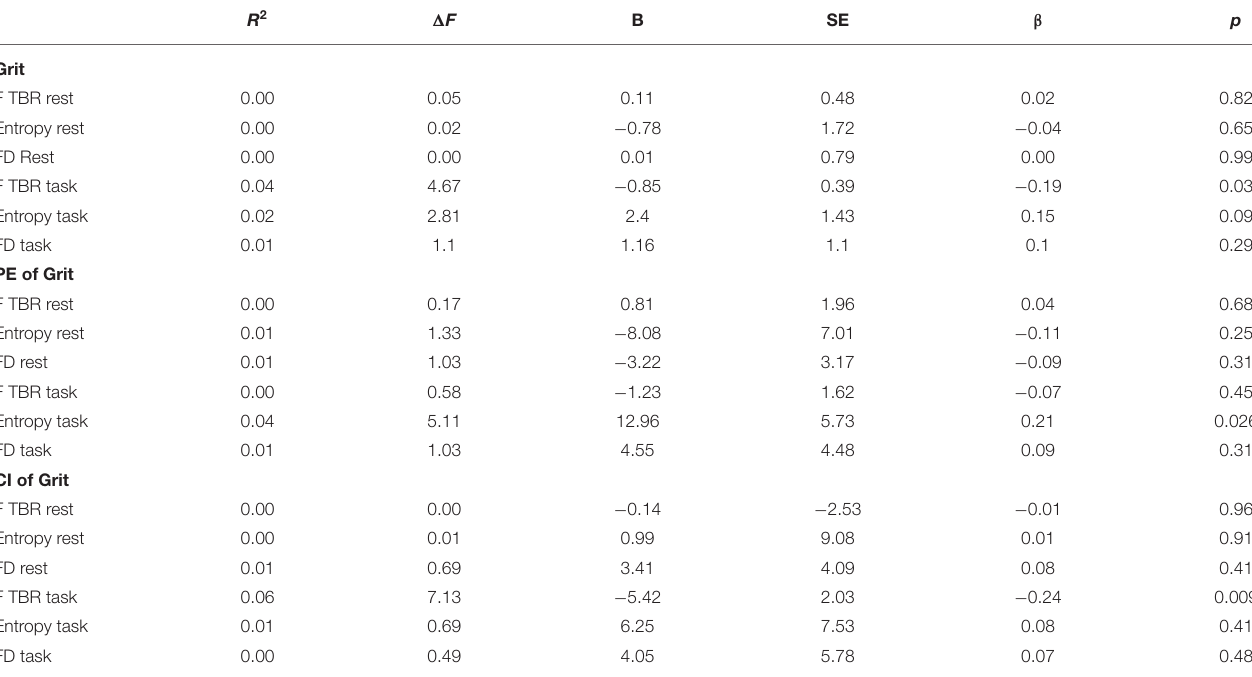
TABLE 2 | Linear regression analyses of grit and its two factors over neural indices (frontal TBR, entropy, and FD) during rest and during the task. R